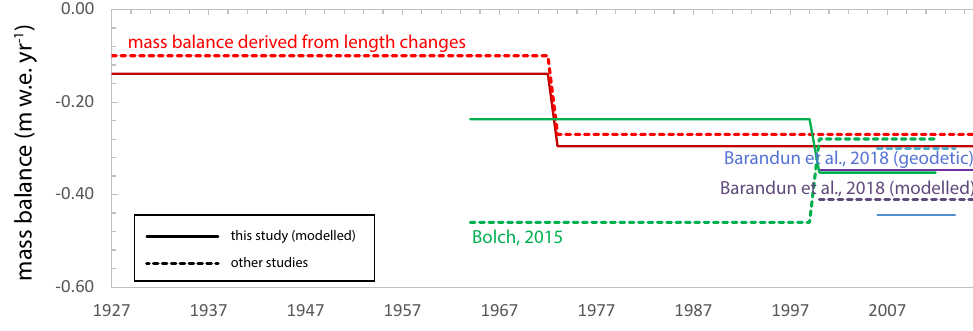
Figure 11. Comparison of reconstructed mass balance averaged for the corresponding period with previous published